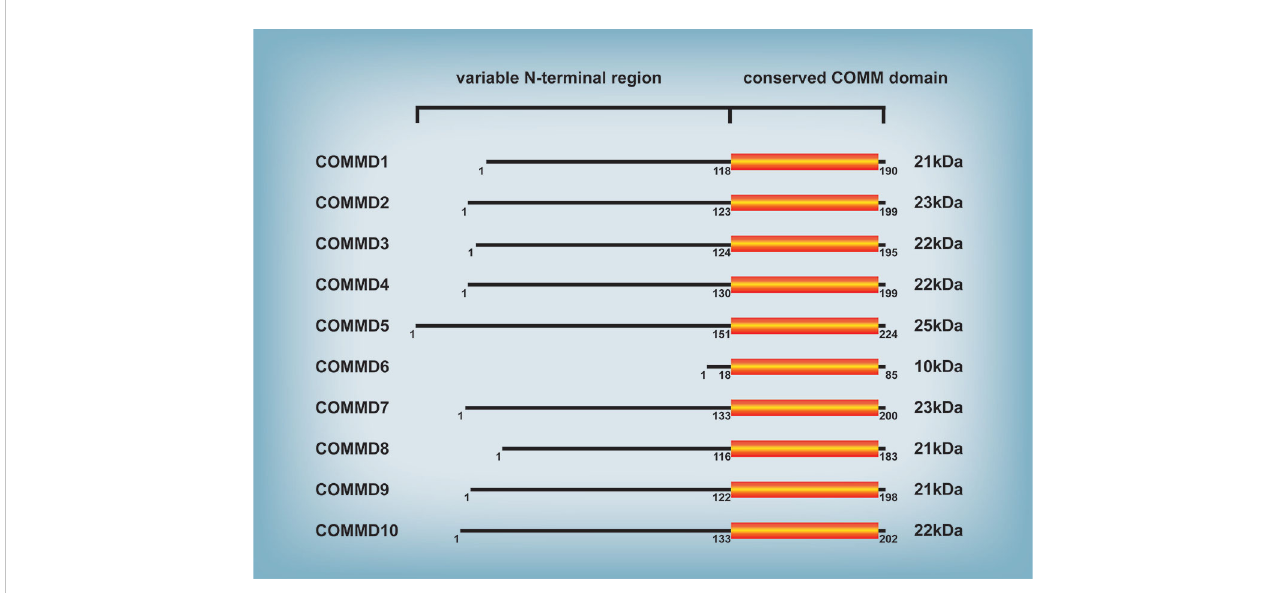
FIGURE 1 COMMD family of proteins. All ten members of the COMMD protein family share a conserved COMM domain. In contrast, the amino terminal domain is highly variable among different COMMD